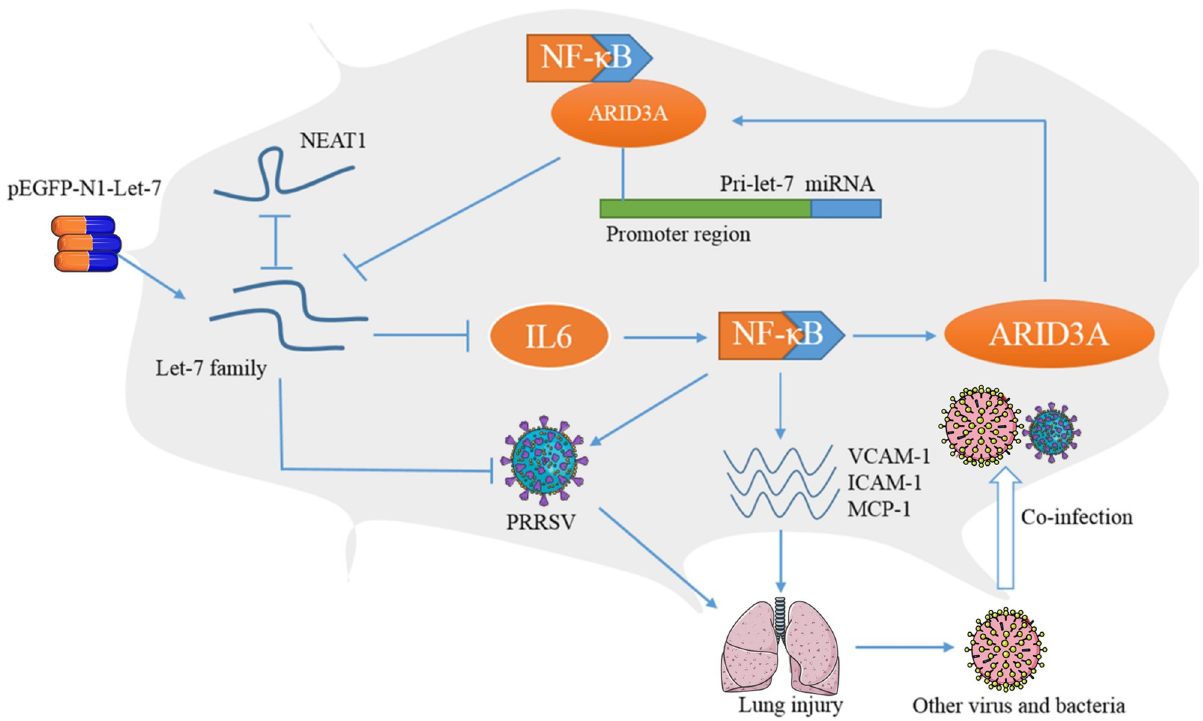
Fig 8. Diagram of NEAT1/ARID3A/NF- κ B/let-7/IL6 regulation during PRRSV-2 infection (drawn using PowerPoint). P arts of Fig 8 were drawn by using pictures from Servier Medical Art, provided by Servier, licensed under a Creative Commons Attribution License.